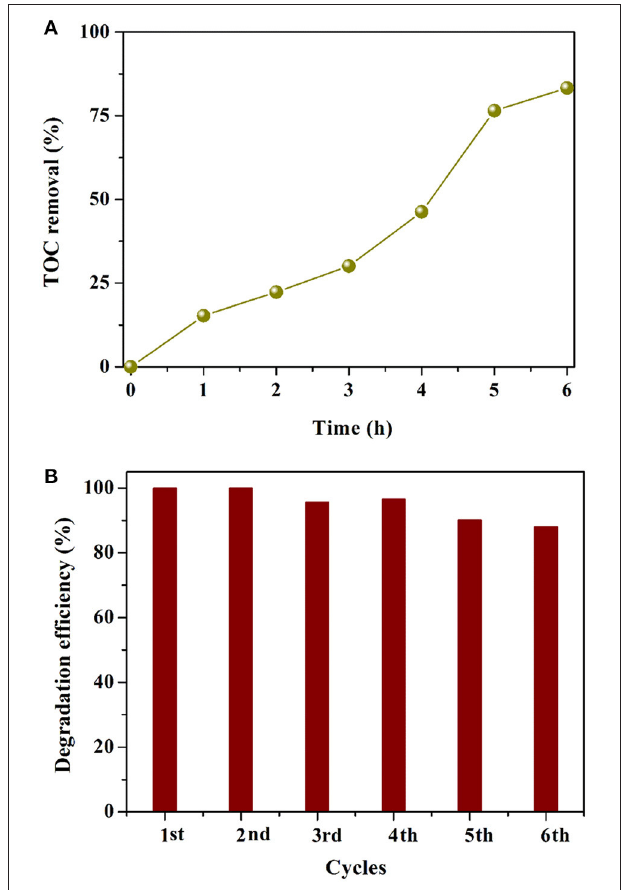
FIGURE 7 | (A) TOC removal curves in the presence of S3. (B) Cycling runs in the degradation of RhB over S3.